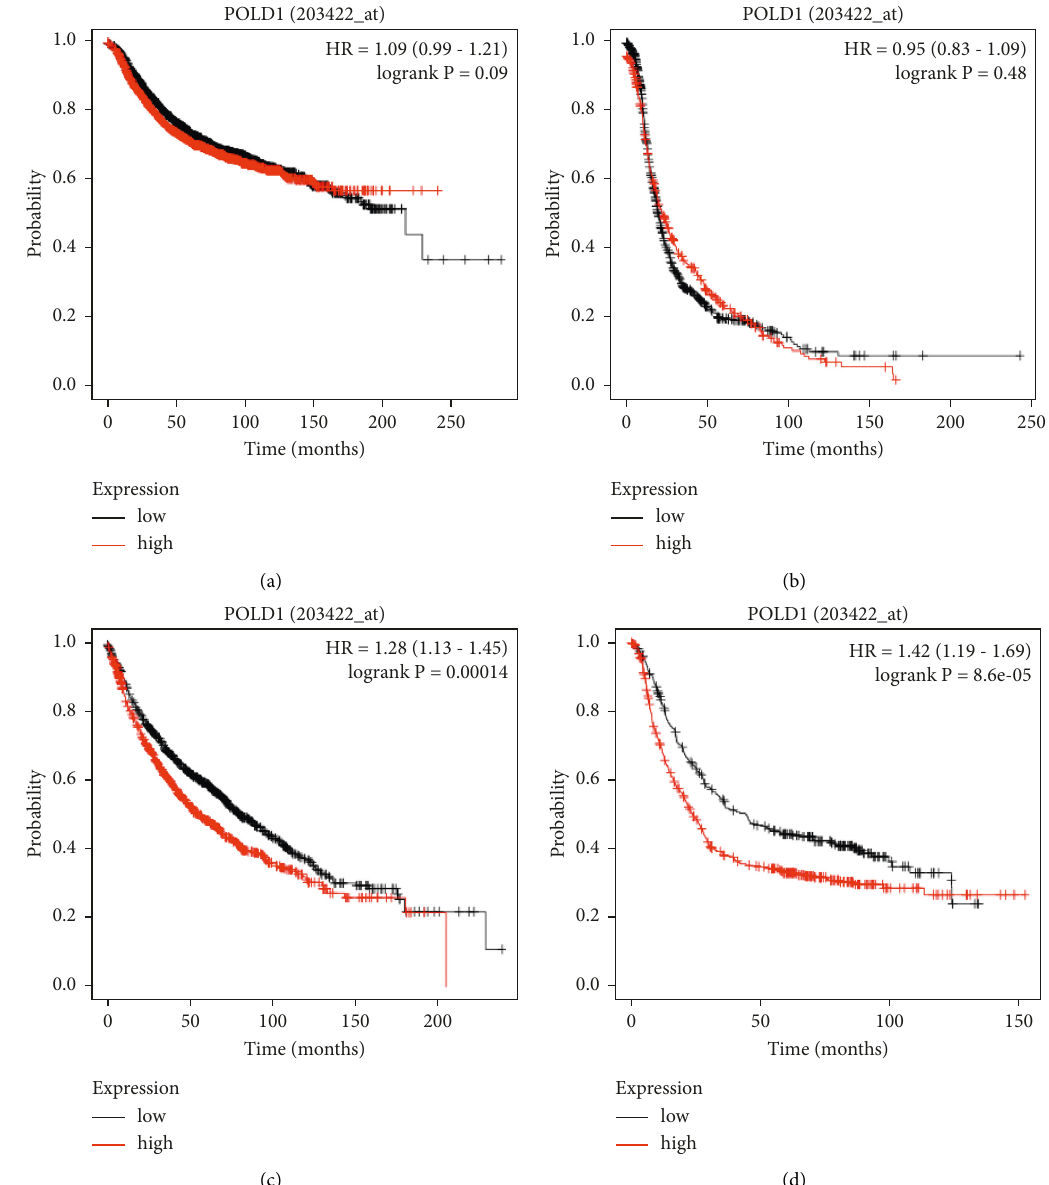
Figure 7: Clinical significance of POLD 1 in (a) breast, (b) ovarian, (c) lungs, and (d) gastric